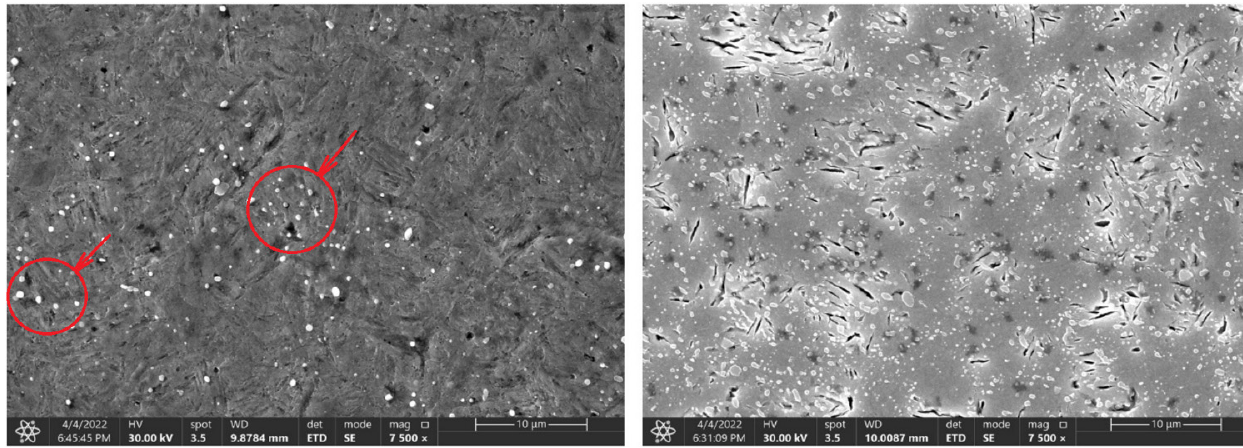
Figure 11. Change in the microstructure of the C105W1 steel, with a heating time of 140 s and 3600 s. 4. Conclusions The method and course of the heat treatment has a major influence on the final form of the steel. The difference between an ideally and incorrectly performed heat treatment is manifested both in a change in the mechanical properties and microstructure. Using non-destructive acoustic emission methods, the start and end time of phase transfor- mations can be effectively monitored and accurately determined, and the resulting time applied to any subsequent heat treatment. For the C45, C105W1, and 80CrV5 steel samples used in this experiment, the heating times required for the austenitic transformation were determined using AE methods. An optimum heating time between 130 s and 140 s was found for all of the samples, after